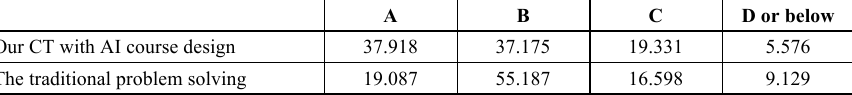
Table 3. Grade distribution of a problem solving techniques course. Listed is the percentage of students getting grades: A, B, C, D or below. We compared two consecutive years: one followed a traditional problem solving style, the other is our approach with CT and AI. A B C D or below Our CT with AI course design The traditional problem